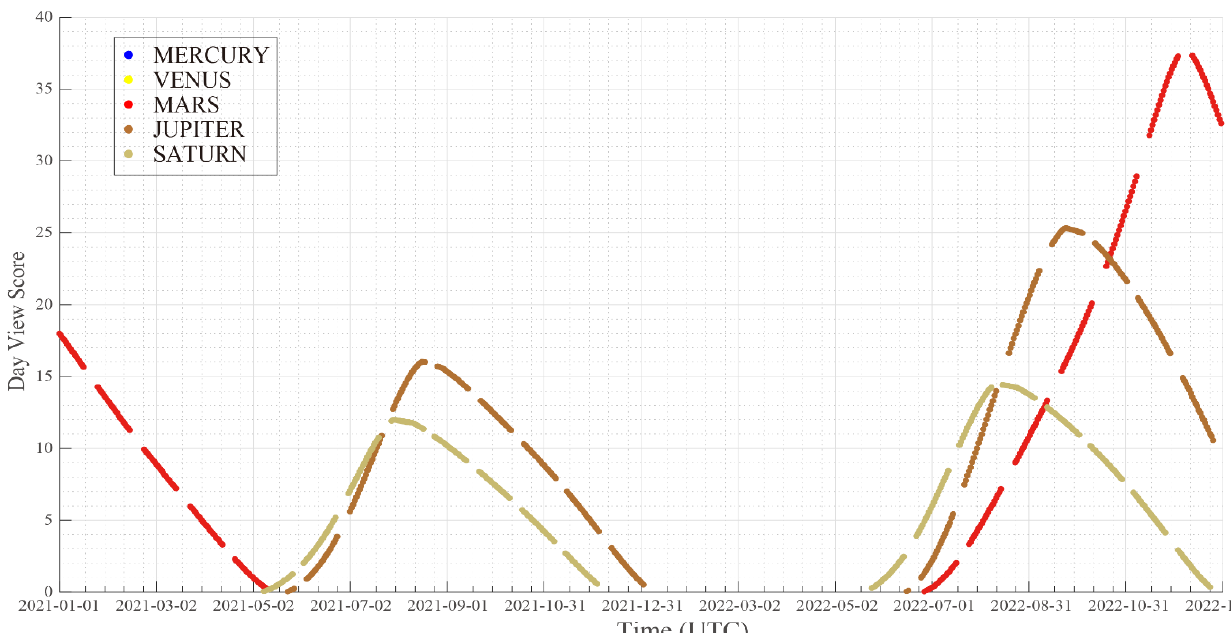
Figure 4. Observation windows from 1 January 2021 to 31 December 2022. Yellow areas denote the time during which the targets are observable, while dark blue areas indicate the time during which the targets cannot be observed. The horizontal axis represents UTC time and the vertical axis is the target.